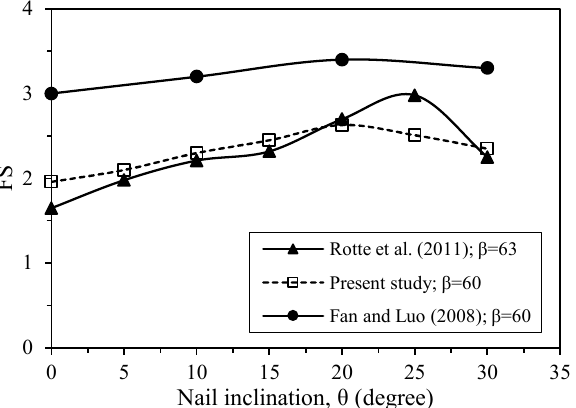
Figure 14. Comparison of FS with nail inclination for current study and existing literature.